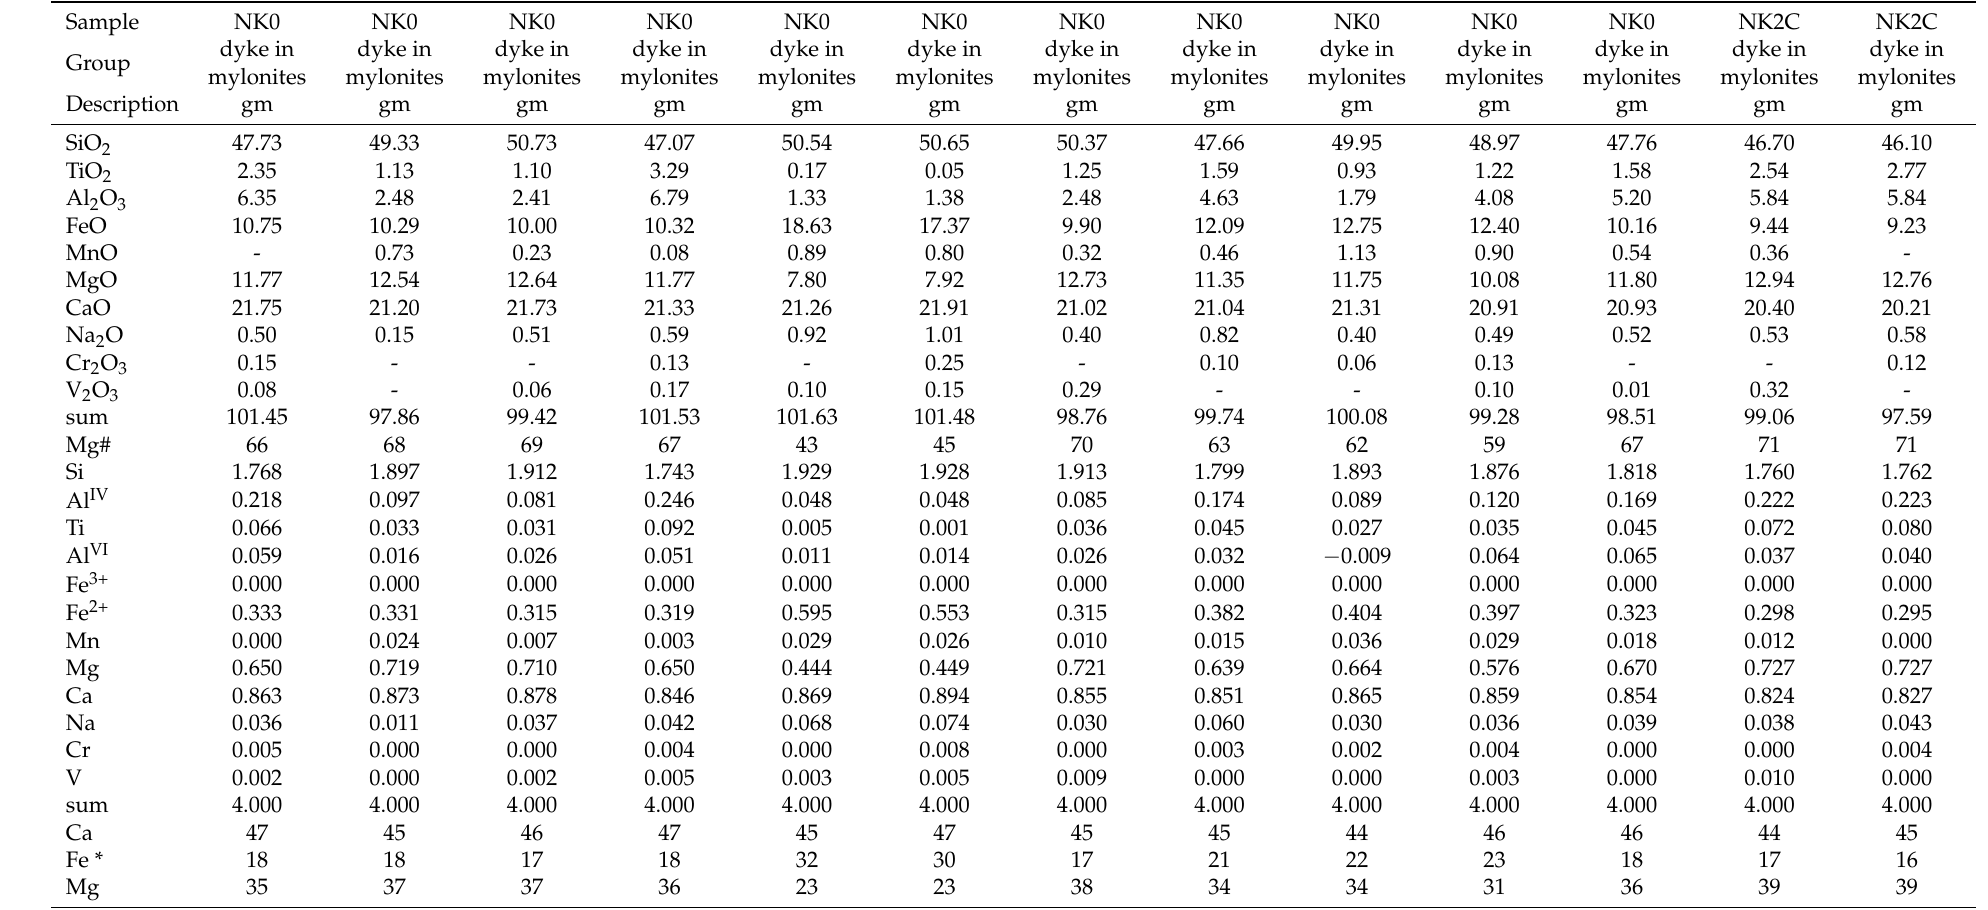
Table 1. Representative chemical analyses (in wt.%) and structural formulas of clinopyroxenes of Njimom dykes (western